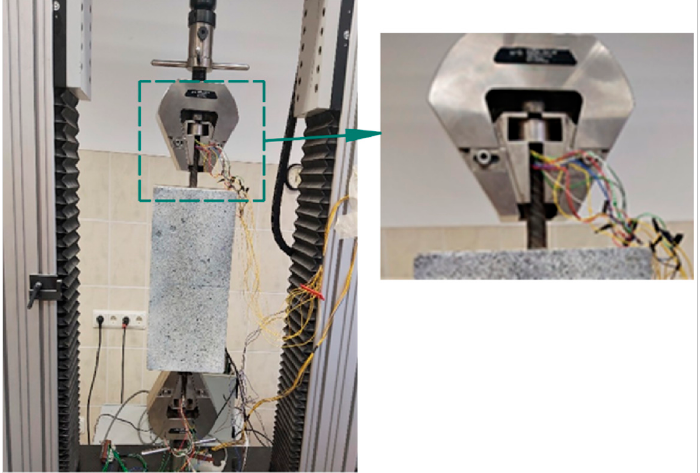
Figure 3. Experimental setup of double pull-out test.